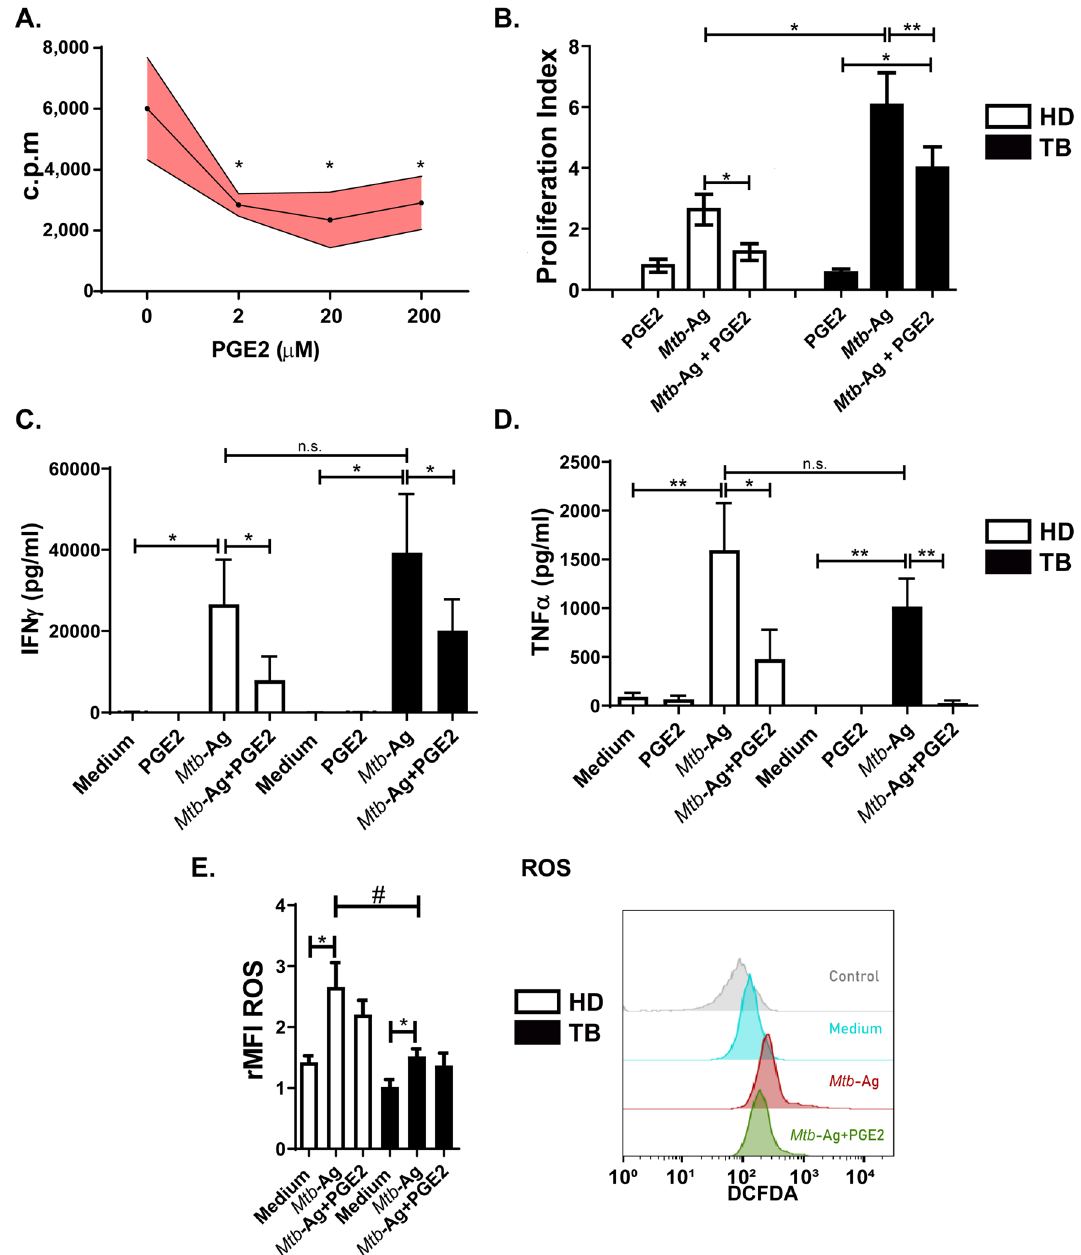
Figure 3. Inhibitory role of PGE2 on several functions of human immune cells. ( A,B ) PBMC from TB patients and/or HD were stimulated with Mtb -Ag (10 µg/ml) in the presence or absence of PGE2 for 5 days. Afterwards, cellular proliferation was analyzed by measuring the incorporation of tritiated thymidine during the last 16 h of culture. ( A ) Dose–response curve of PGE2 (0–200 µM) on proliferation of PBMC from HD (n = 7). ( B ) Effect of PGE2 (2 µM) on cell proliferation from HD (n = 7) and TB patients (n = 6). Bars show the values of the proliferation index (c.p.m. in each condition/c.p.m. media) ± SEM. ( C,D ) PBMC from HD (n = 5) and TB patients (n = 4) were stimulated with Mtb -Ag (10 µg/ml) in the presence or absence of PGE2 (2 µM) for ( C ) 5 days or ( D ) 24 h. Afterwards, the production of ( C ) IFNγ and ( D ) TNFα were determined by ELISA. Each bar represents the mean of cytokine production (pg/ml) ± SEM. ( E ) Neutrophils from HD (n = 5) and TB patients (n = 5) were incubated with 2 ʹ ,7 ʹ -dichlorofluorescein diacetate (DCFDA, 50 µM) for 15 min and then stimulated with or without Mtb -Ag (10 µg/ml) ± PGE2 (2 µM) for 60 min. Finally, DCFDA fluorescence was evaluated to monitor ROS production by flow cytometry. Left panel: Bars represent the mean values of the mean fluorescence intensity relative to control (rMFI) of neutrophils ± SEM. Right panel: a representative histogram is shown (Control: non-stained cells). Statistical differences were calculated using one-way ANOVA and post hoc Dunnett’s multiple comparison test. * p < 0.05, ** p <